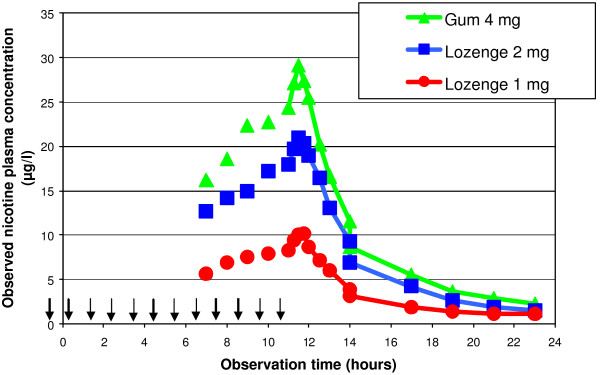
Nicotine plasma concentration after repeated intake of nicotine lozenges or gum (31 subjects). Nicotine plasma concentrations were determined from blood samples of 31 volunteers drawn before hourly administration of 1 or 2 mg nicotine lozenge or 4 mg nicotine gum (unconnected data points). Consecutive blood samples (connected data points) were drawn after administration of dose 12 (t = 11 h).